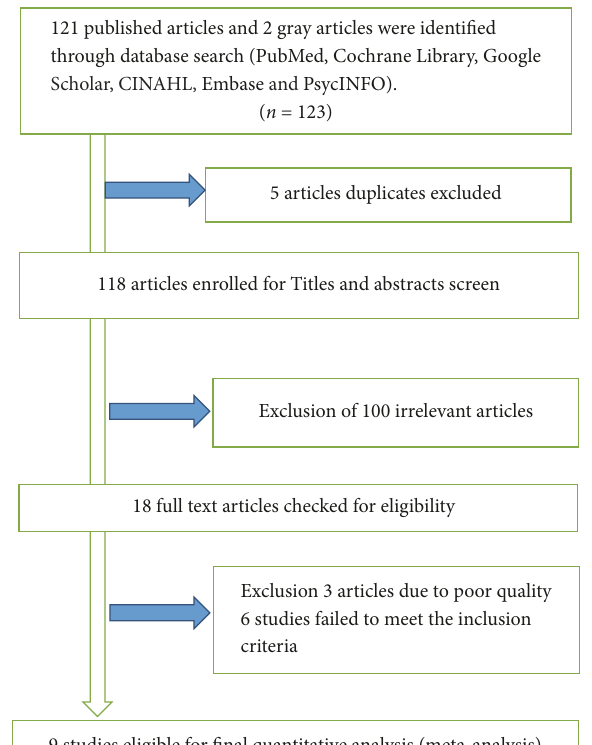
Figure 1: Flowchart of study selection for meta-analysis of preva- lence of depression among diabetic patients in Ethiopia,